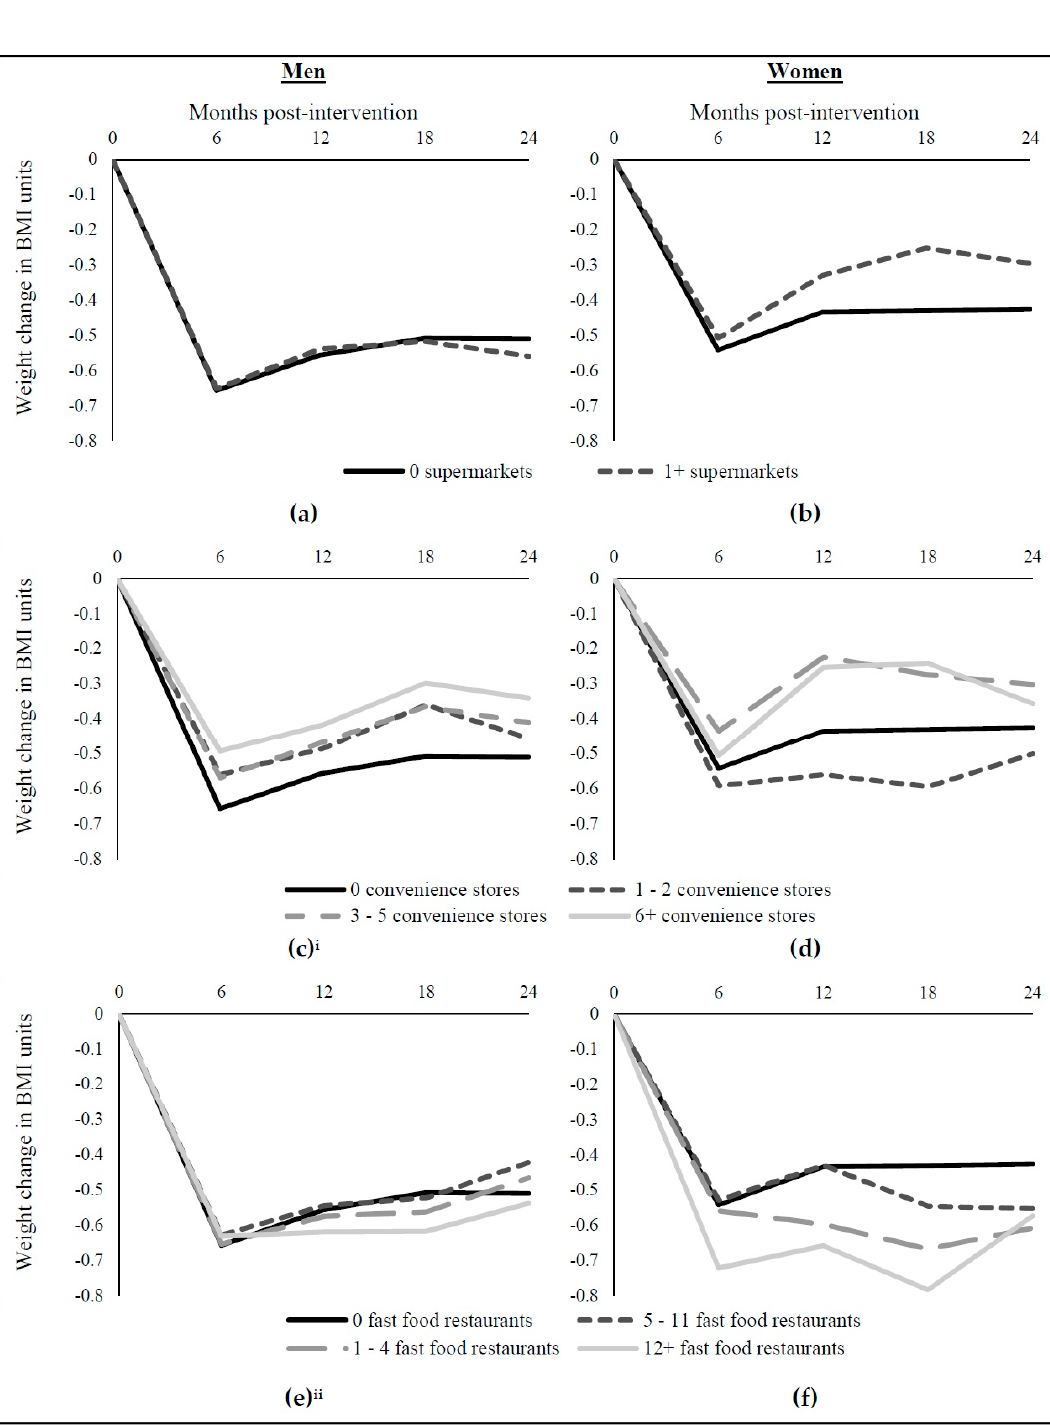
Figure 2. MOVE! effect on 12-, 18-, and 24-month BMI Change (as well as on Initial 6-month BMI Change) by Supermarket Access for ( a ) Men and ( b ) Women; Convenience Store Access for ( c ) Men and ( d ) Women; and Fast Food Restaurant Access for ( e ) Men and ( f ) Women. i : Statistically significant difference in MOVE! effect between men with no food outlets and men with low (1–2 stores) convenience store access at 18 months ( p < 0.05) and 24 months ( p < 0.05) and at 6 months for men with low ( p < 0.01), medium (3–5 stores) ( p < 0.05) and high (6 + stores) ( p < 0.001) convenience store access; ii : Statistically significant difference in MOVE! effect for men with low (1–4 restaurants) fast food restaurant access ( p < 0.05) at 24 months.